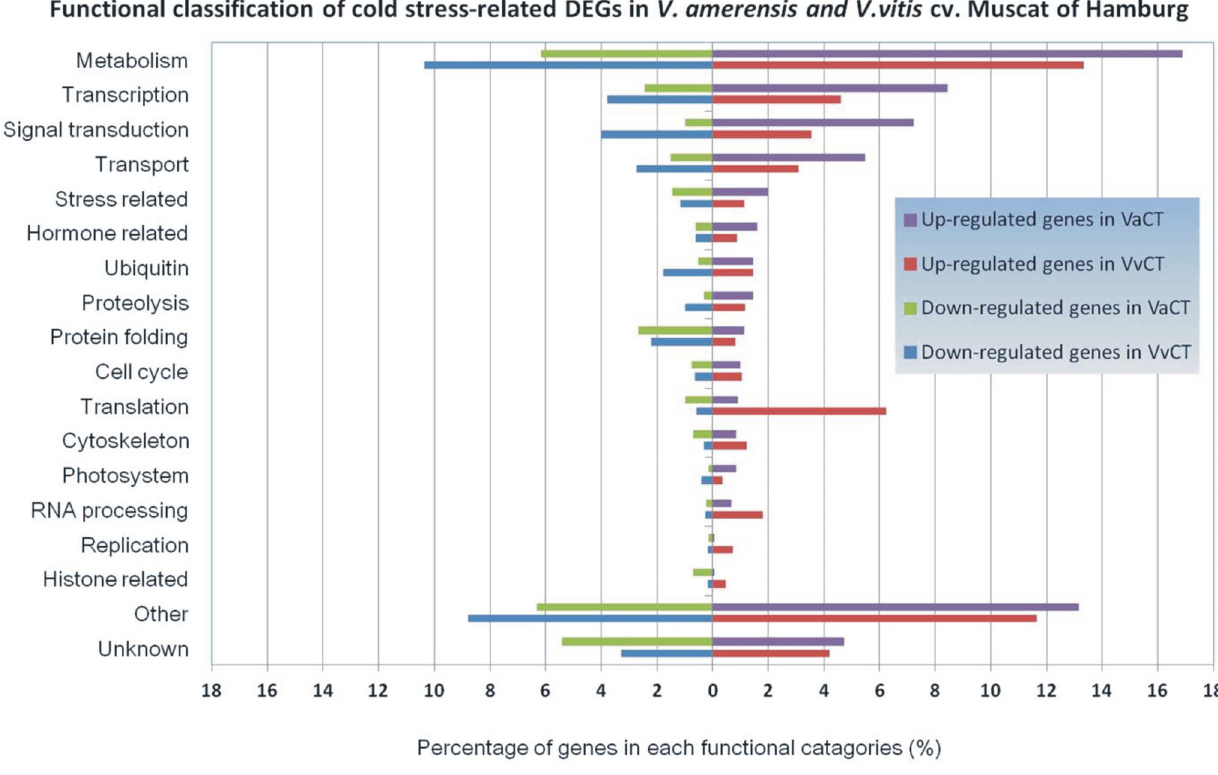
Figure 2. Functional classification of cold stress-related DEGs in V.amurensis and V.vinifera cv. Muscat of Hamburg. Identified DEGs were classified into functional categories and the percentage of up- or down-regulated functional categories were shown here. The DEGs with BLASTx annotation but that could not be classified into any of the functional categories were clustered into ‘‘Other’’. Transcripts without any annotation information from BLASTx program were collected into ‘‘Unknown’’.